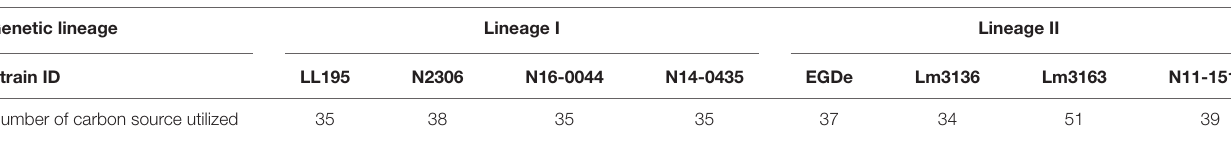
TABLE 2 | Number of C-sources utilized 1